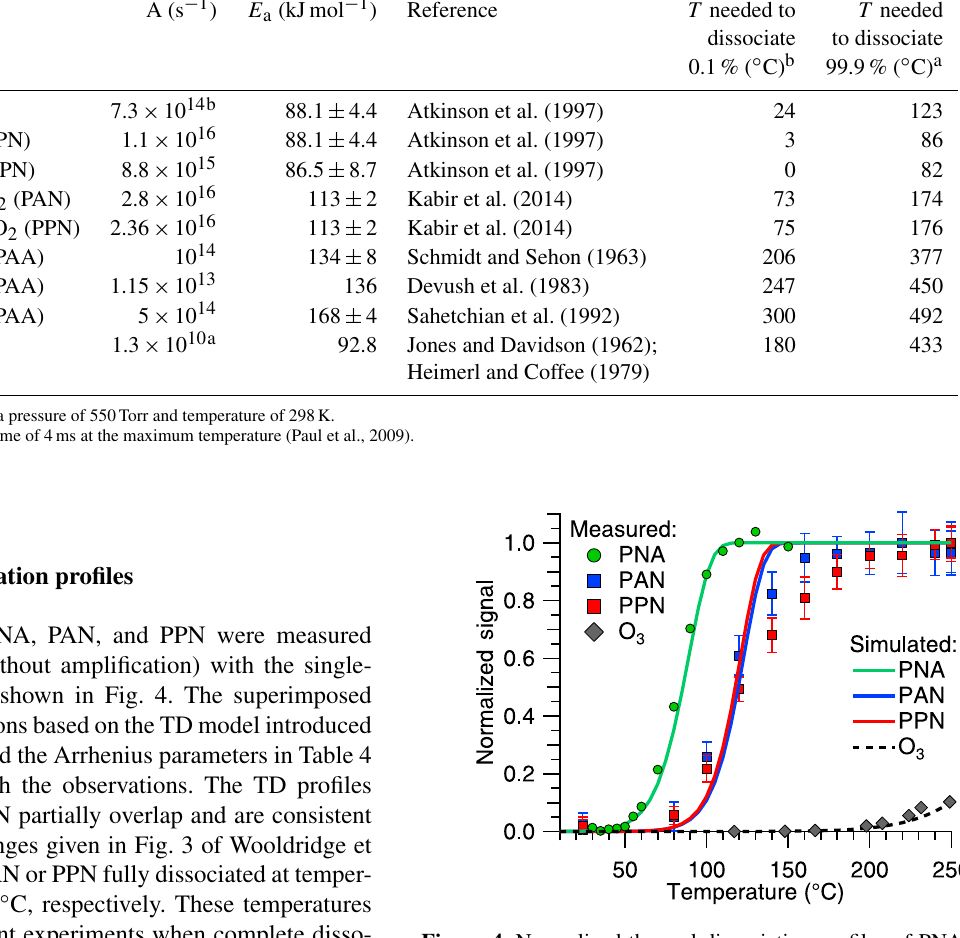
dissociate to dissociate 0.1% ( ◦ C) b 99.9% ( ◦ C) a